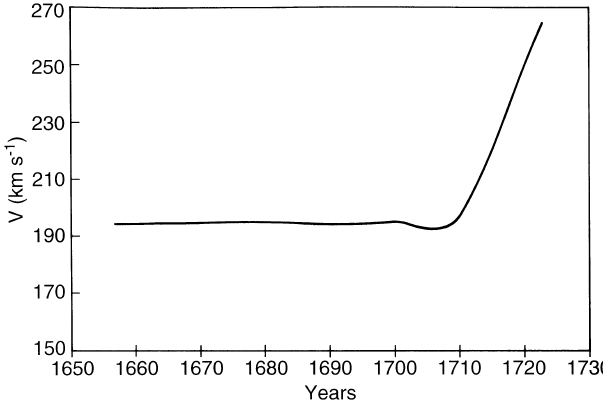
Fig. 4. Solar-wind velocity at Earth’s orbit during the Maunder minimum obtained from Eq. (6). The values correspond to the 7 years of solar minima, occurring during